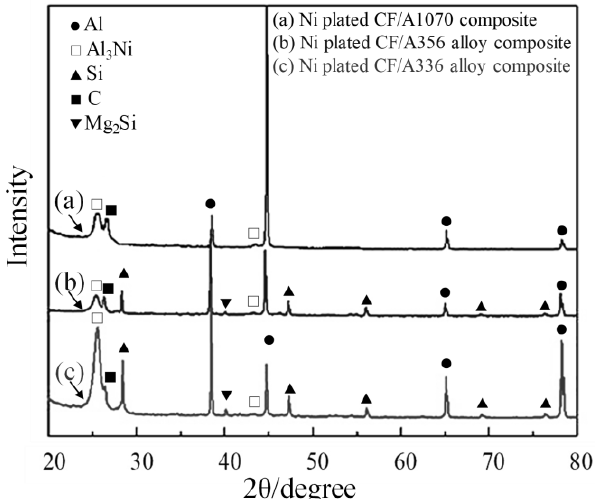
Figure 6. Results of X-ray diffraction spectra of composites: ( a ) Ni plated CSF/A1070 composite, ( b ) Ni plated CSF/A356 alloy composite, and ( c ) Ni plated CSF/A336 alloy composite.